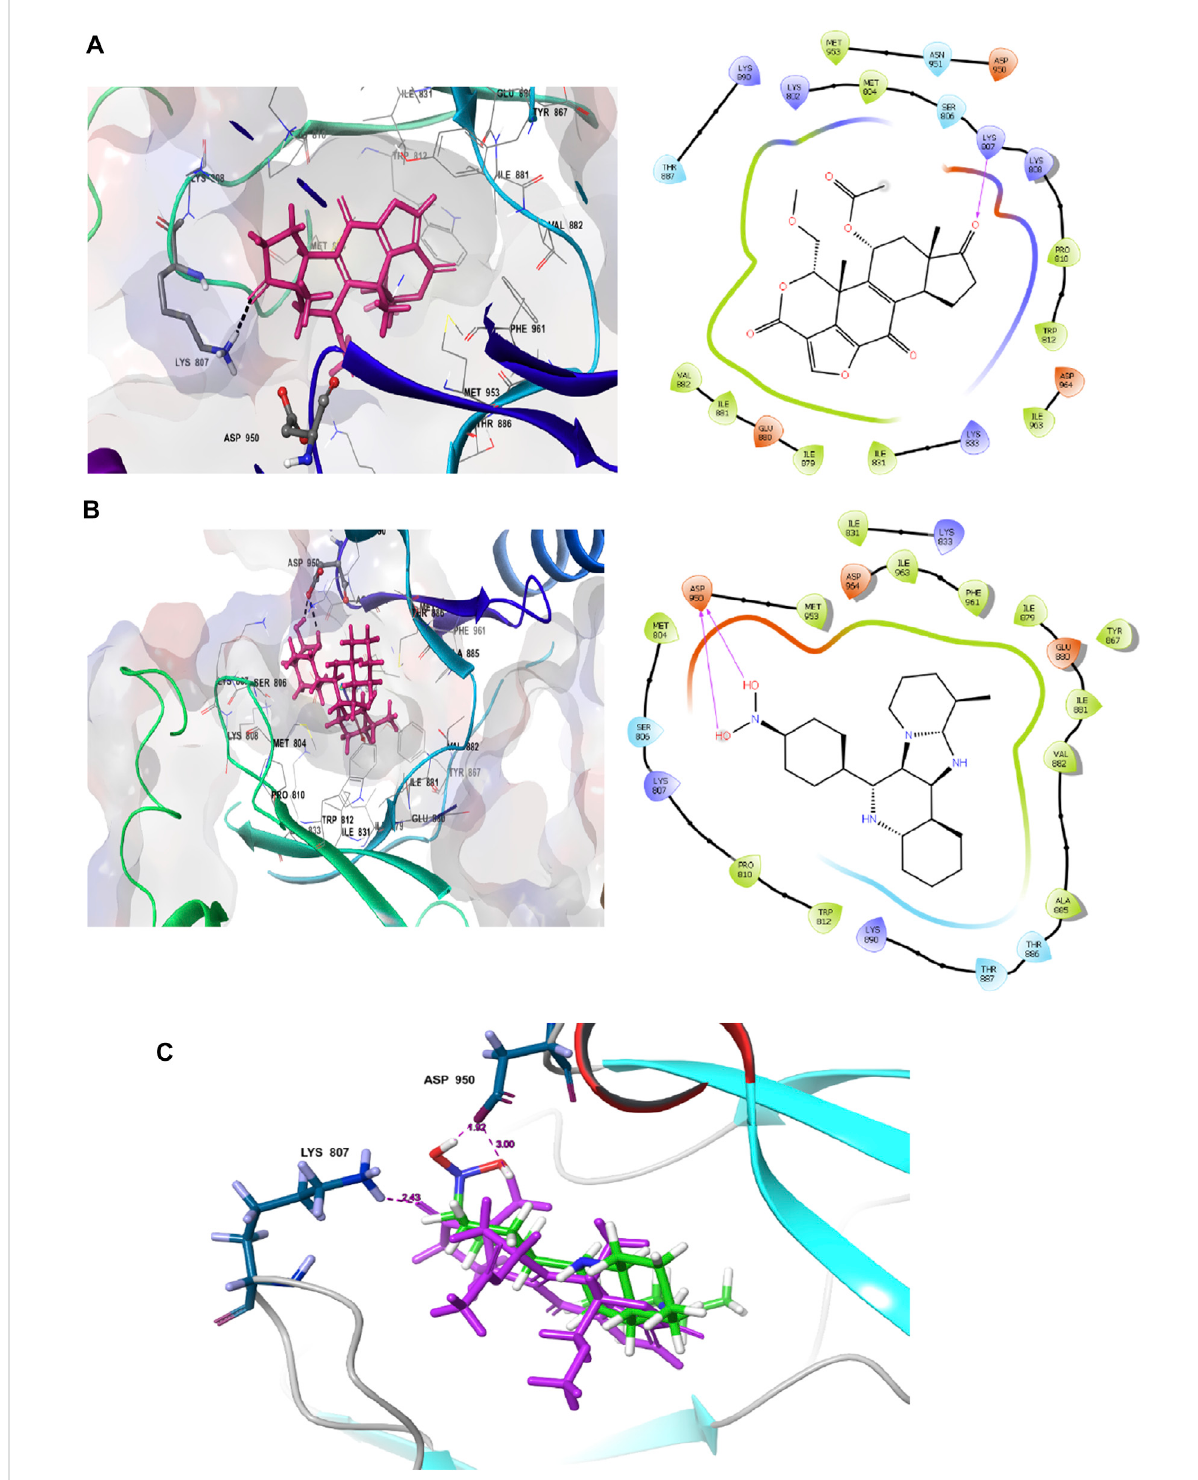
FIGURE 3 Ligand interaction analysis of the (A) Wortmannin, (B) compound 1j and (C) The superimposed view of wortmannin (green) and 1j (violet) with target receptor.